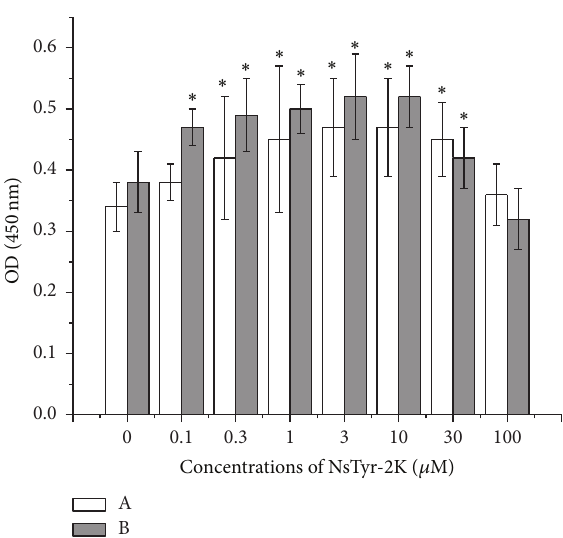
Figure 6: The time course of NSPCs viability after coincubation with different concentrations of NsTyr-2K. Cell viability was measured by the CCK-8 assay. The concentration of NsTyr-2K was 0.1, 0.3, 1, 3, 10, 30, and 100 𝜇 M, respectively. The error bars represent the standard error of the mean (S.E.M.) of at least three experiments ( 𝑛 = 3 ). ∗ 𝑃 < 0.05 , ∗ 𝑃 < 0.05 versus control group. (A) Six days, (B) 9 days.